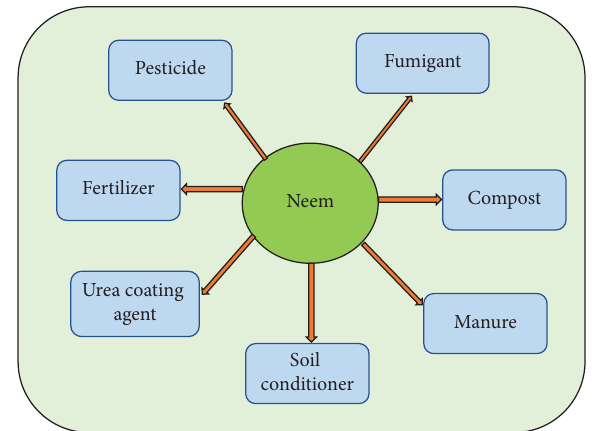
Figure 1: Various applications of neem in the feld of agriculture